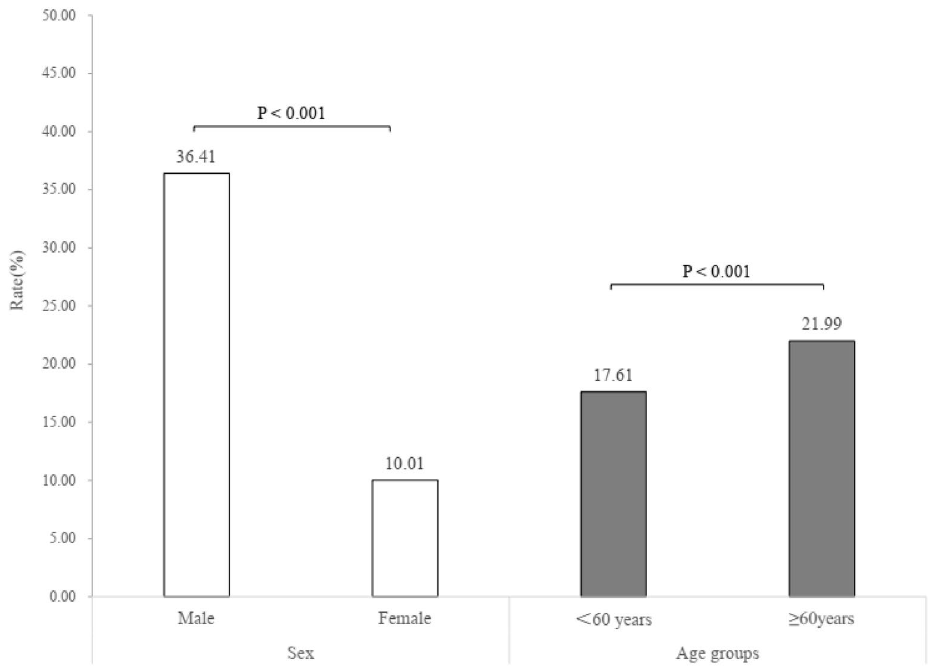
Figure 3. The high risk (≥ 10%) of 10-year ASCVD risk estimation by sex and age